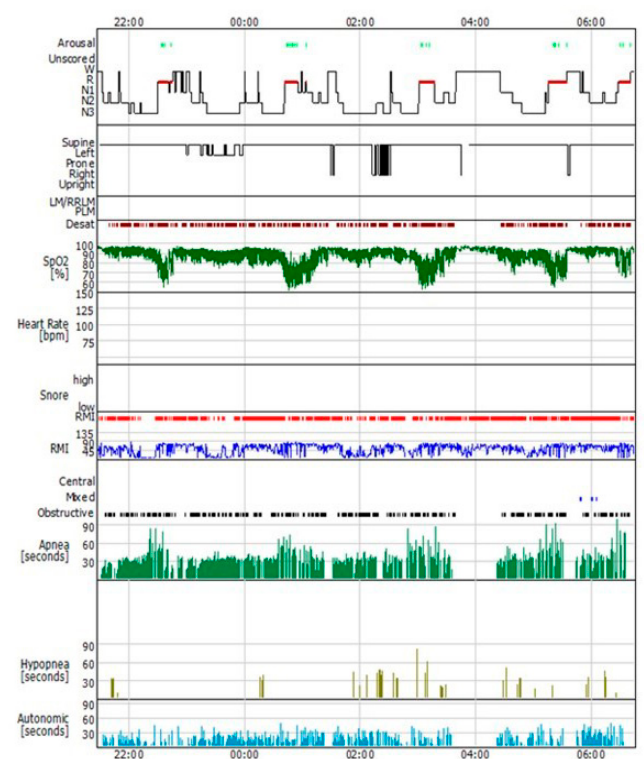
Figure 3. Predominantly obstructive apneic events (OSA). OSA with more than 90% of the respiratory events are obstructive apneas, characterized by a high UA collapsibility. Legend: OSA: obstructive sleep apnea; UA: upper airways.